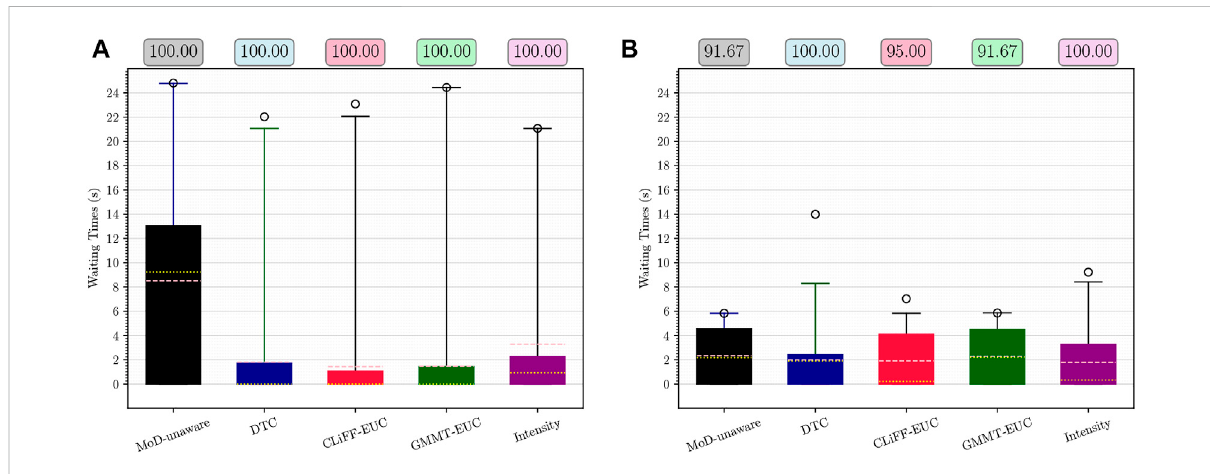
FIGURE 12 Waitingtimesandsuccessrate(ontop)forScenario1 (A) andScenario2 (B) fromPedSimwarehouseenvironment.Meansareshowninpinkand medians in yellow.